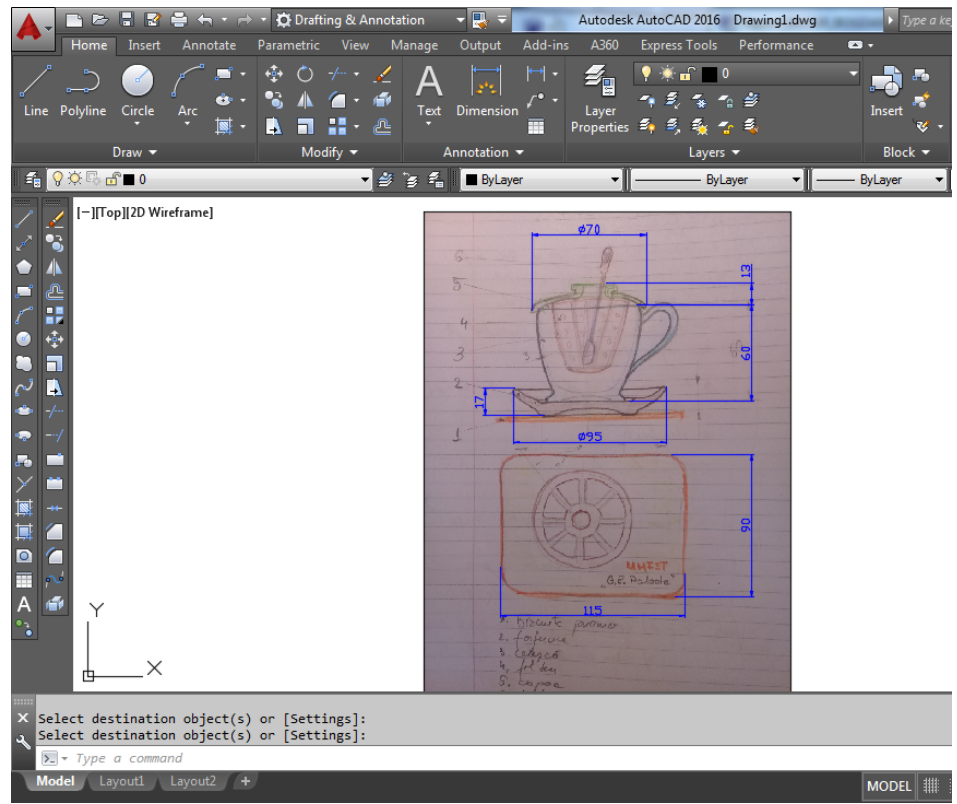
Figure 4. Insert/scale sketch drawing by hand in the AutoCAD environment. (1) promo biscuit holder, (2) saucer, (3) teacup, (4) separator filter, (5) lid, (6) stirring spatula